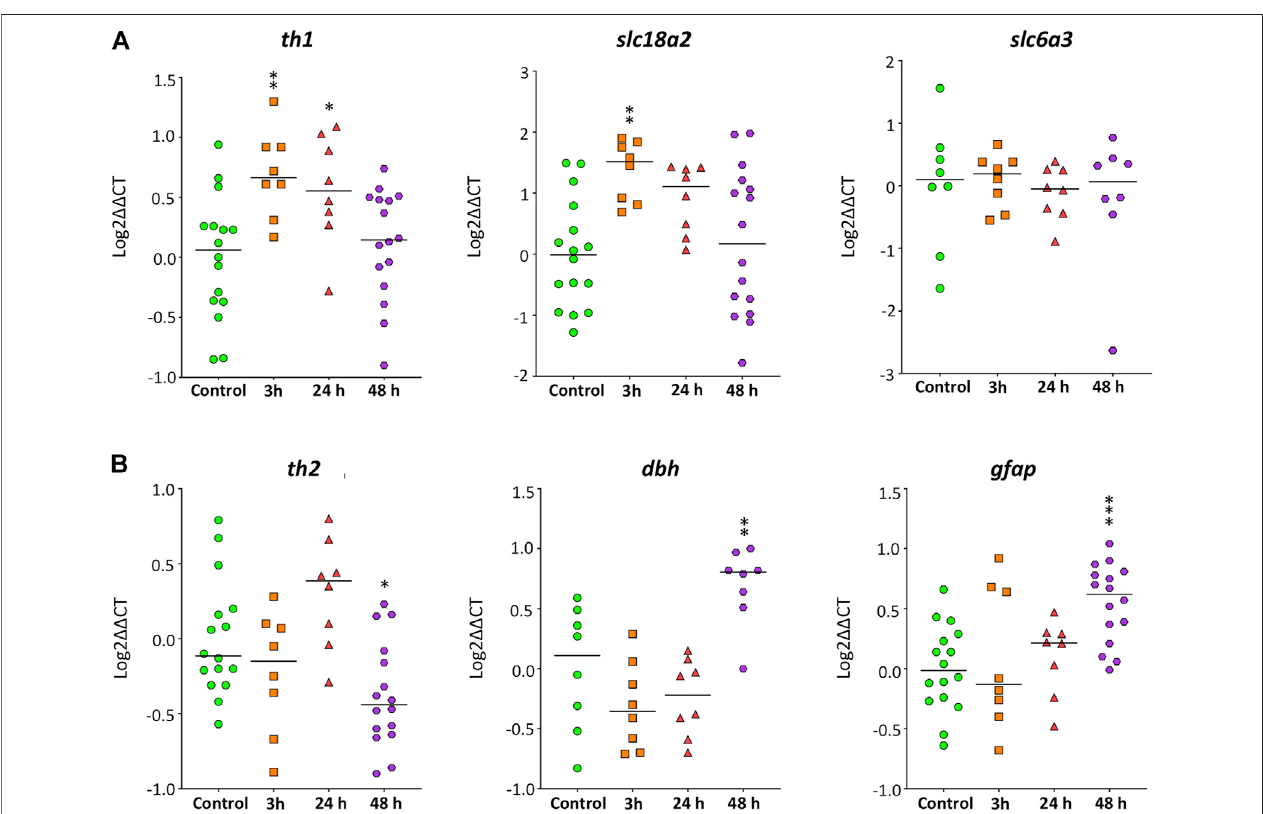
FIGURE 6 | Time-course of the expression of genes involved in the synthesis and transport of catecholamines and neuroin fl ammation in zebra fi sh brain after waterborne exposureto40 mg/l methamphetamine. (A) Expression of th1 and slc18a2, but nor slc6a3 exhibitsanearly response tomethamphetamine. (B) Expression of th2 , dbh and gfap exhibits a late response. Data reported as scatter plot with the median. * p < 0.05, ** p < 0.01; one-way ANOVA with Dunnett ’ s multiple comparison test ( th1 , th2 , dbh , slc18a2 ) or Kruskal Wallis test with Bonferroni correction ( slc6a3 , gfap ). Data from two to three independent experiments ( n (cid:2) 8 – 16 for th1 , th2 and gfap and n (cid:2) 8 for slc18a2 , dbh and slc6a3